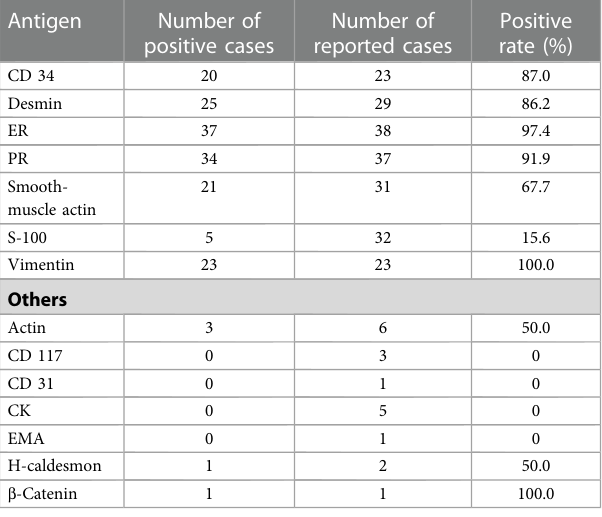
TABLE 3 Misdiagnosis in preliminary diagnosis. Misdiagnosis